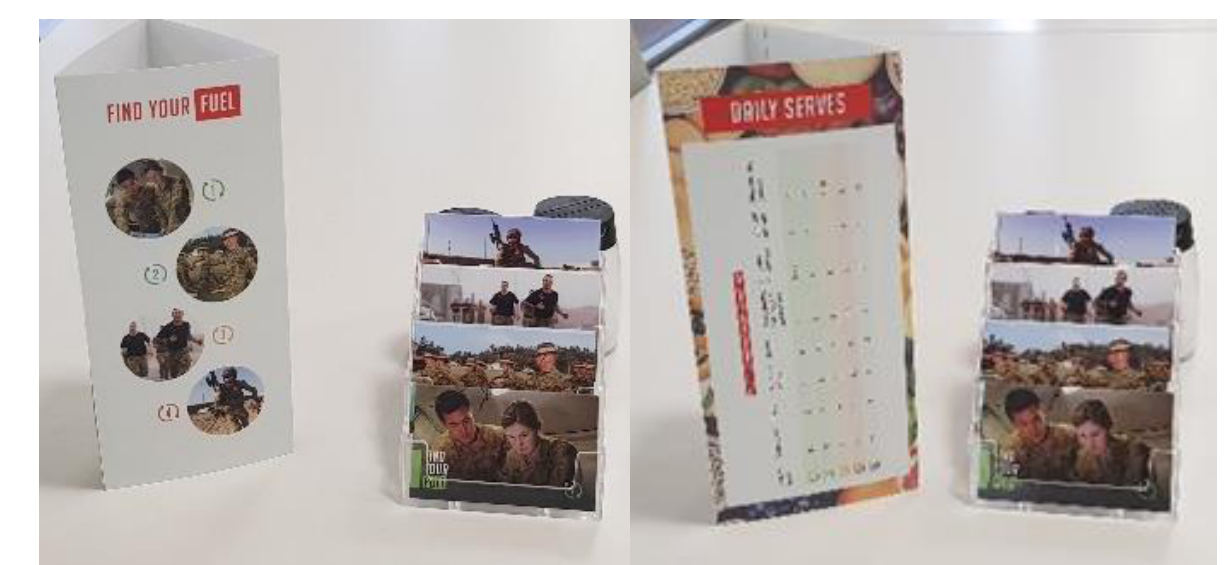
Figure 2. Table talkers and cards (positioned on tables).